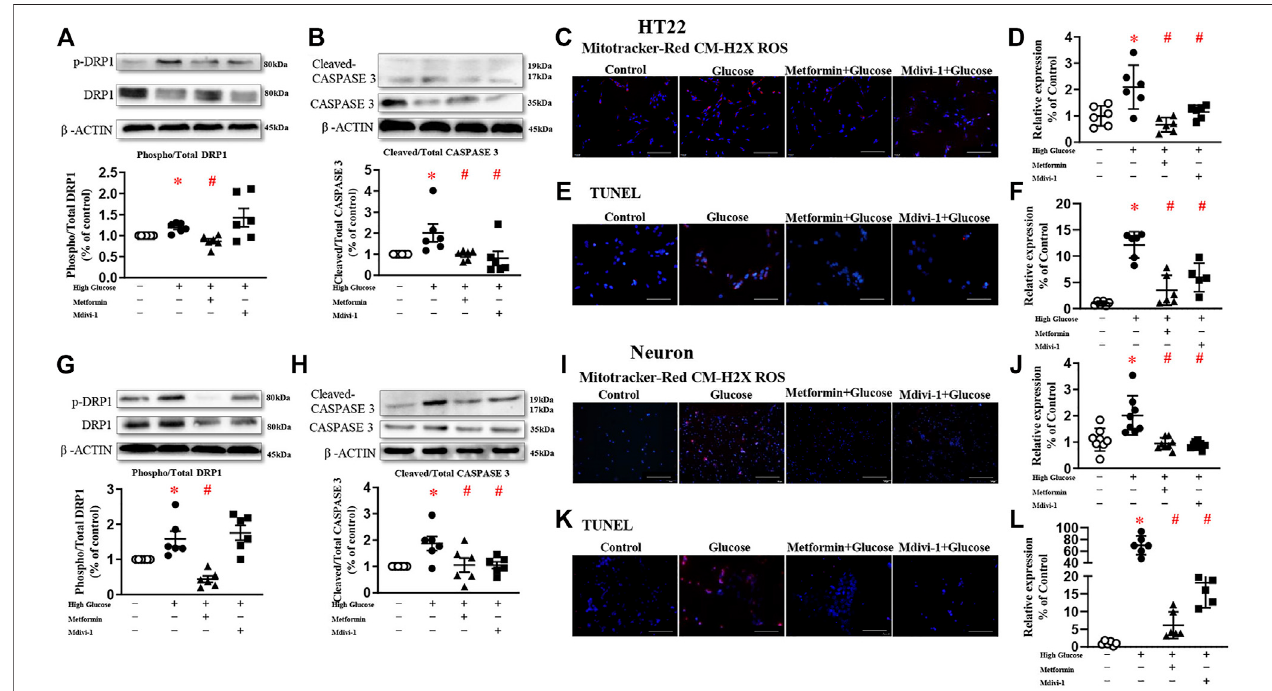
FIGURE 3 | Inhibition of mitochondrial fi ssion decreases oxidative stress and reduces apoptosis in HT22 ( (A – F) , upper panel) and neurons ( (G – L) , lower panel). Representative blots and densitometric quanti fi cation of phosphorylated DRP1 and caspase 3 in HT22 (A – B) and neurons (G – H) . The phosphorylation of DRP1 (top blots) was normalized to total DRP1 protein (middle), and total DRP1 was normalized to β -ACTIN (bottom). The cleaved of caspase3 (top blots) was normalized to caspase3 protein (middle), and caspase3 was normalized to β -ACTIN (bottom). Fluorescent signals and quanti fi cation of Mitotracker-Red CM-H2X ROS in HT22 (C – D) and primary neurons (I – J) stimulated with high glucose (200 ×, Bar = 800 µm). Fluorescent TUNEL signals and quanti fi cation in HT22 (E – F) and primary neurons (K – L) stimulatedwithhighglucose.(200×,Bar=800